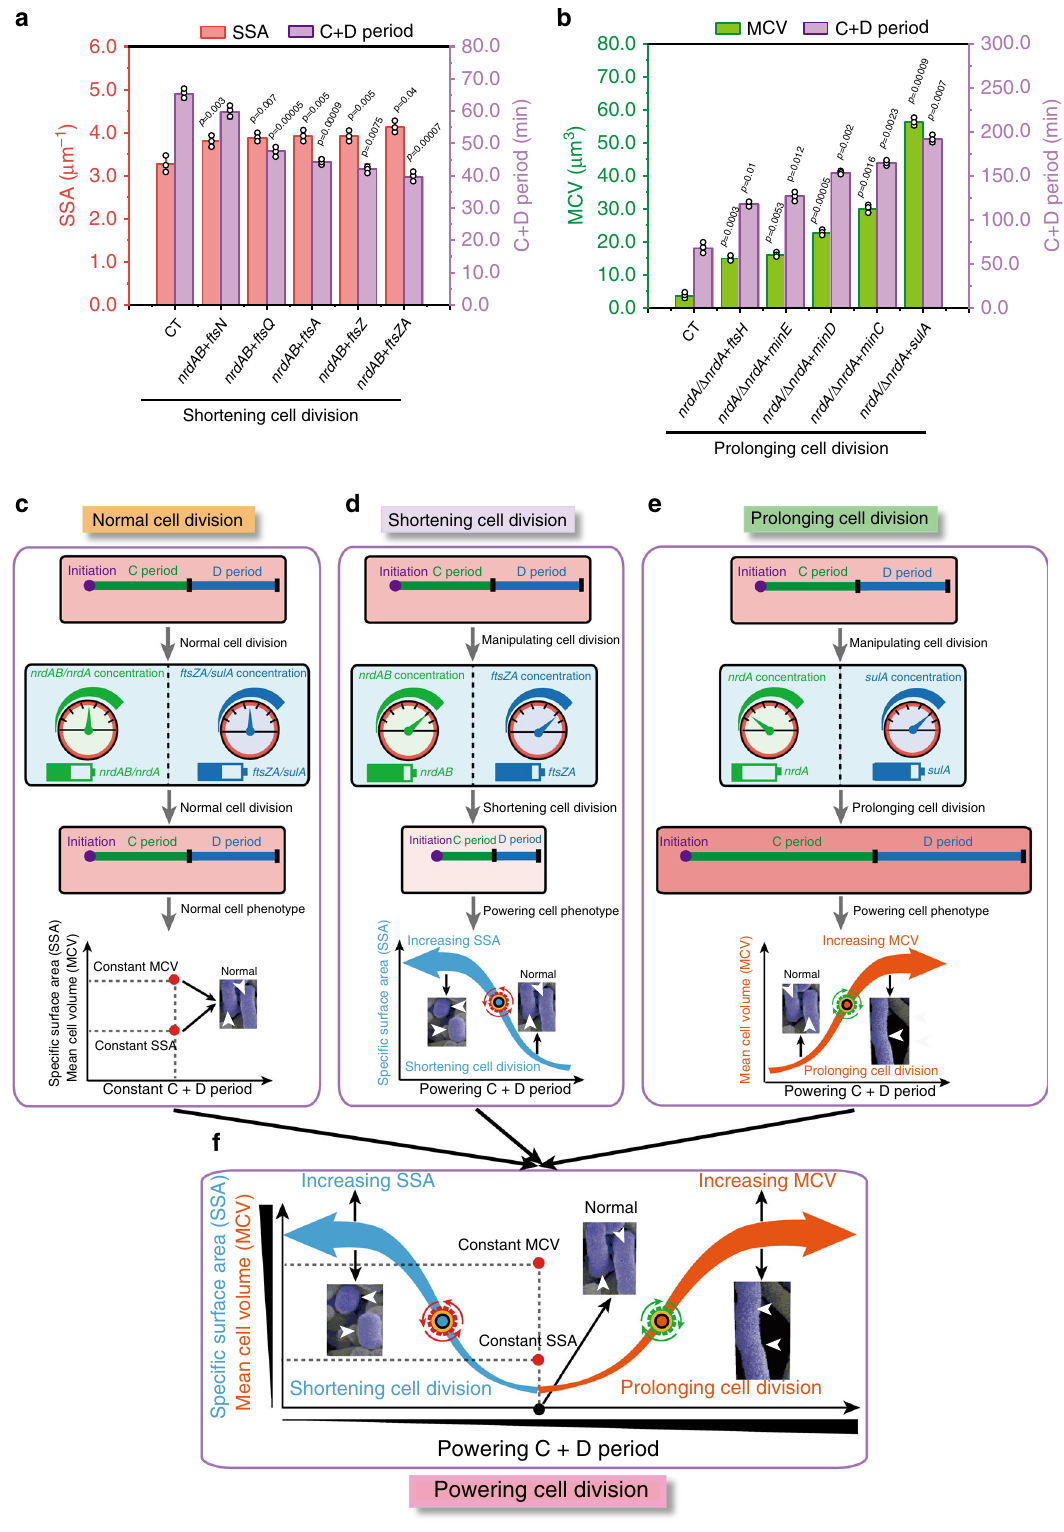
Fig. 3 Combination of the C and D periods of cell division. a Combining the C and D periods for shortening cell division. b Combining the C and D periods for prolonging cell division. c Effect of normal cell division on cell morphology and the C + D periods. d Effect of shortening cell division on cell morphology and the C + D periods. e Effect of prolonging cell division on cell morphology and the C + D periods. f Engineering the C + D periods of cell division for improving speci fi c surface area (SSA) or mean cell volume (MCV). Signi fi cance ( p -value) was evaluated by two-sided t -test, compared to CT. a , b Values are shown as mean ± s.d. from three ( n = 3) biological independent replicates. Source data underlying Fig. 3a, b are provided as a Source data fi